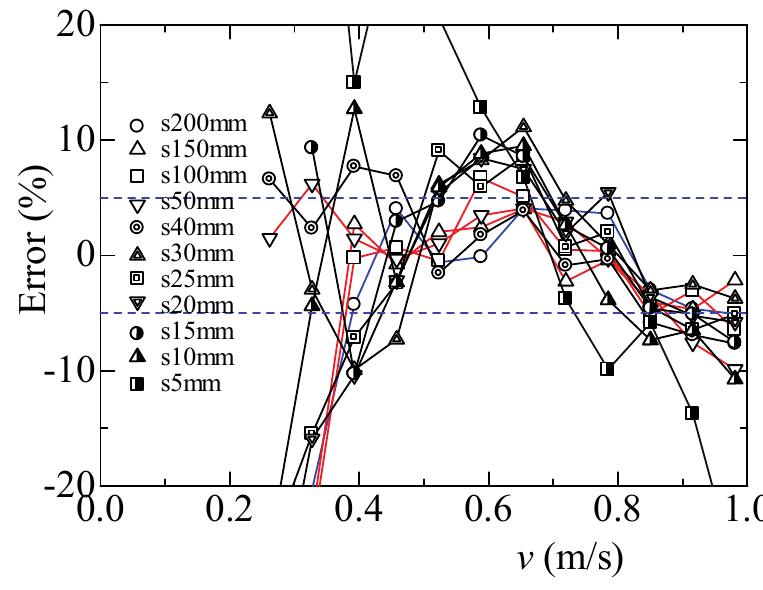
Fig. 7. The error of the guess flow velocity for every submerge depth . observed for every underwater circular cylinder